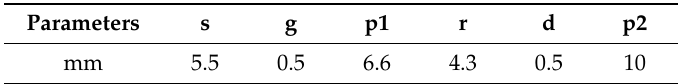
Table 1. Parameters of the frequency selective surfaces (FSSs) shown in Figure